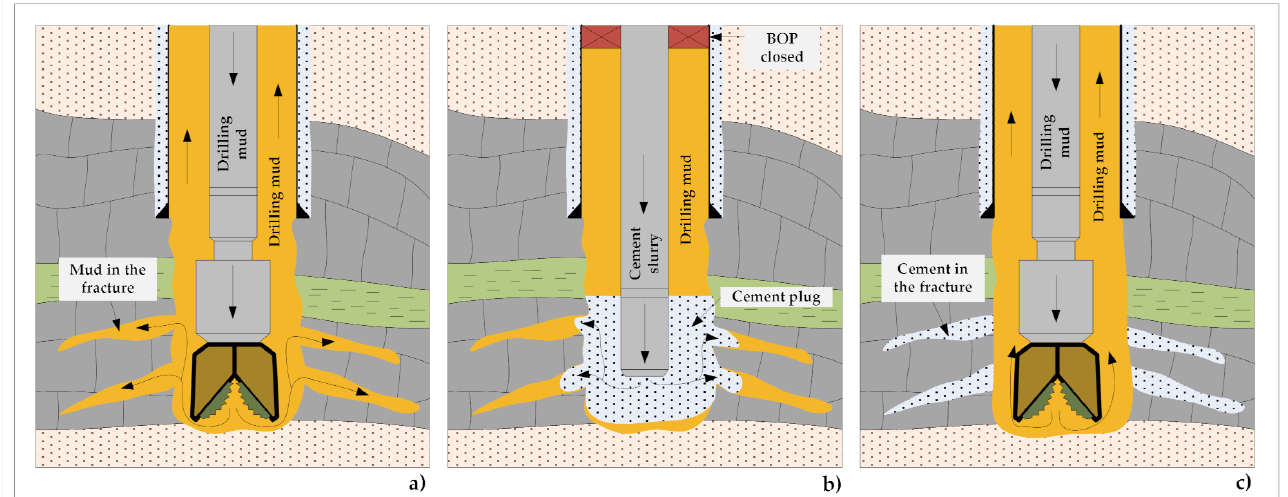
Figure 5. Plugging the thief zone with the thixotropic cement slurry: ( a ) loss of mud during drilling, ( b ) pumping and spotting of a thixotropic cement slurry into thief zone, ( c ) the situation in the well after hardening of the cement slurry into set cement of sufficient strength to withstand various stresses in the